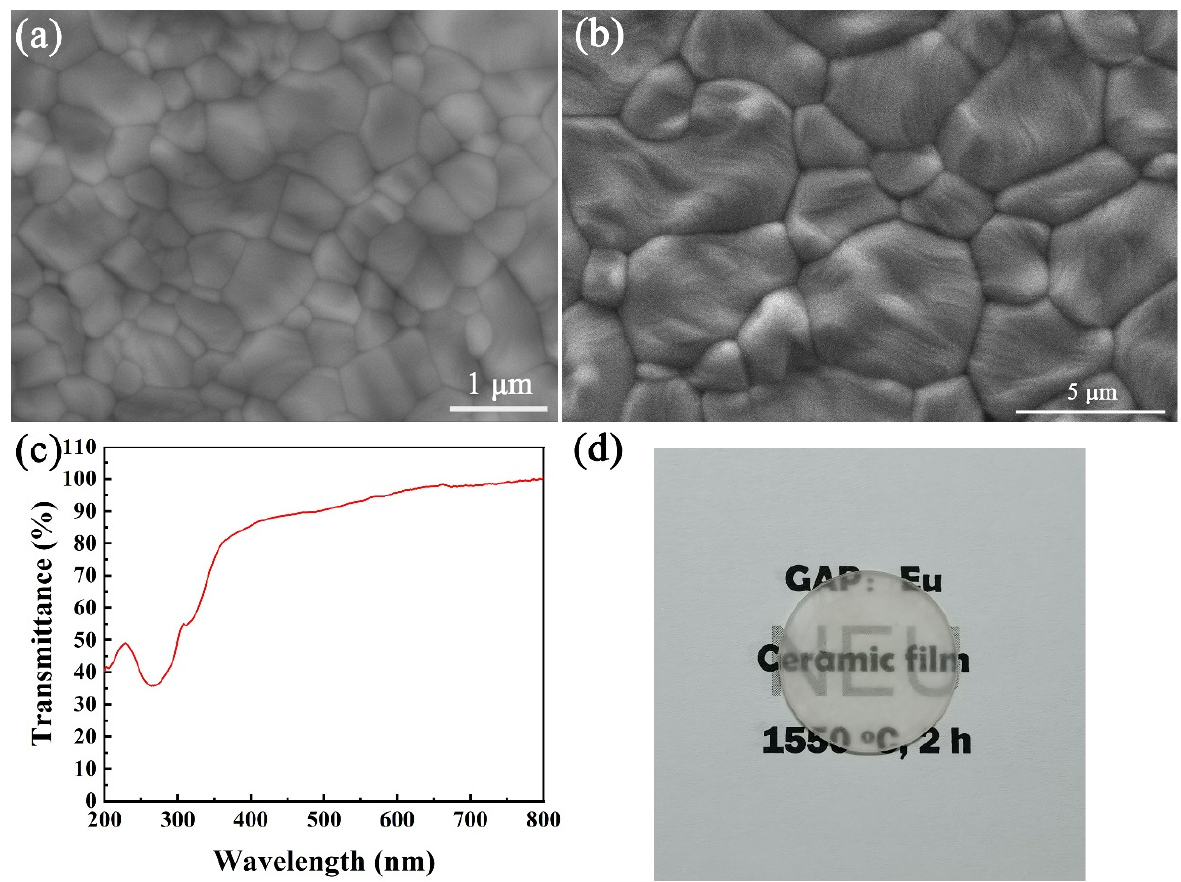
Figure 5. ( a,b ) FE-SEM images of the ceramic film calcined at 1300 °C and 1550 °C. ( c ) Transmittance curve and ( d ) appearance of the ceramic film calcined at 1550 °C.